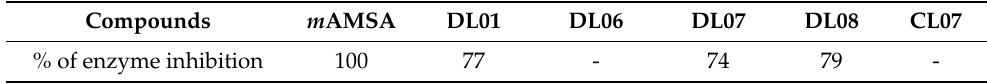
Table 2. Topo II α inhibition activity of acridine